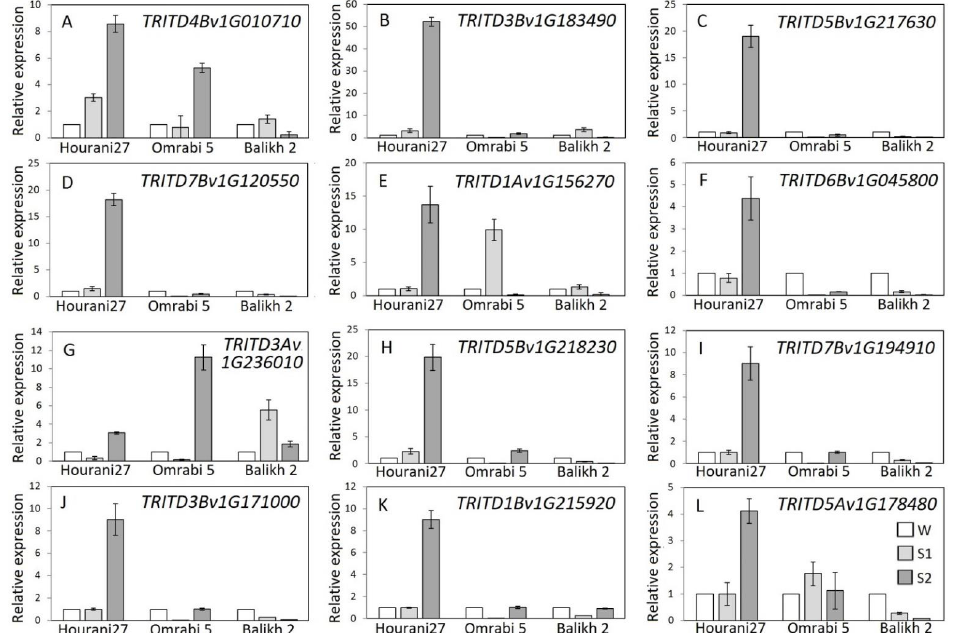
Figure 4. Relative expression of drought-responsive memory genes (indicated in the upper left corner of each panel) in three durum wheat cultivars (Hourani 27, Omrabi 5 and Balikh 2) during S1 and S2 stress stages as compared to the control W. Each subgraph ( A – L ) represent a different gene (gene name is located in the upper right corner of each subgraph). The actin 1 amplification was used as an internal reference gene. Data represent means ± 95% CI.